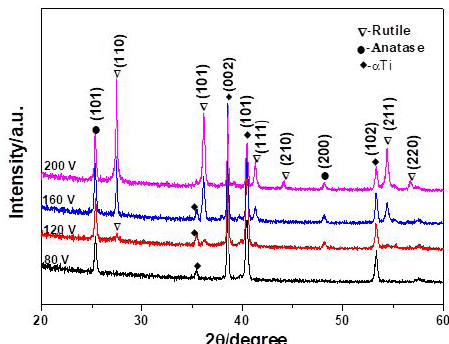
Figure 2. XRD patterns of the MAO coatings applied various voltages.